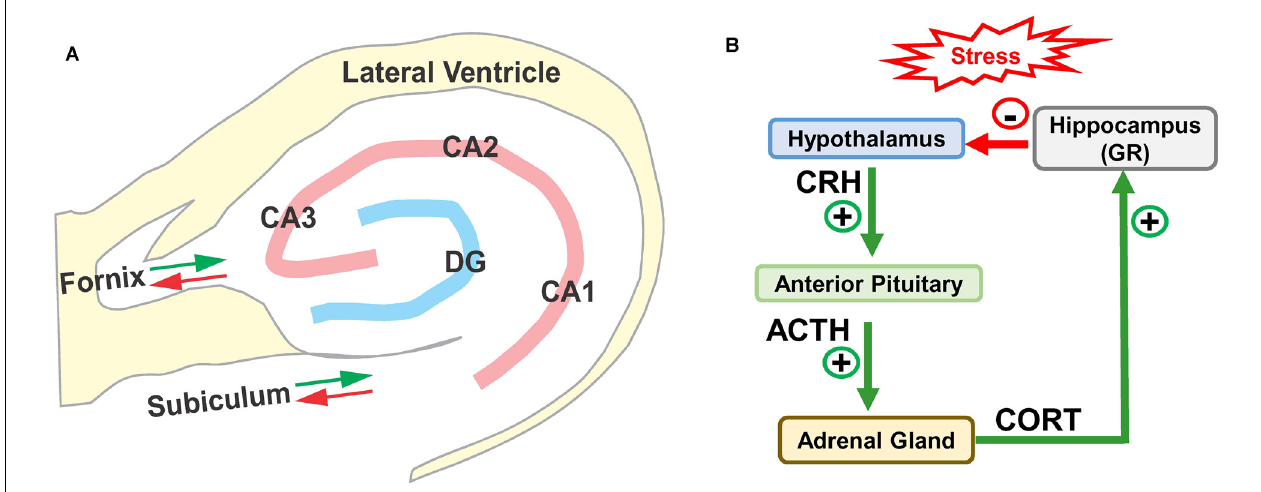
FIGURE 1 | (A) Schematic of hippocampus and surrounding lateral ventricle. Three subdivisions of the rodent Cornu Ammonis (CA1, CA2, and CA3) surrounding the dentate gyrus (DG). Only the major afferent and efferent pathways (red/green arrows) through the subiculum and fornix are shown. (B) Schematic of hypothalamic-pituitary adrenal (HPA) axis with hippocampus. Stress stimulates the release (+) of corticotropic releasing hormone (CRH) from the hypothalamus, which binds to receptors in anterior pituitary causing the release (+) of adrenocorticotropic hormone (ACTH) which stimulates the release of corticosterone (CORT). CORT binds to glucocorticoid receptors (GRs) in the hippocampus, which provides negative feedback ( − ) to the hypothalamus suppressing the release of CRH, ACTH, and